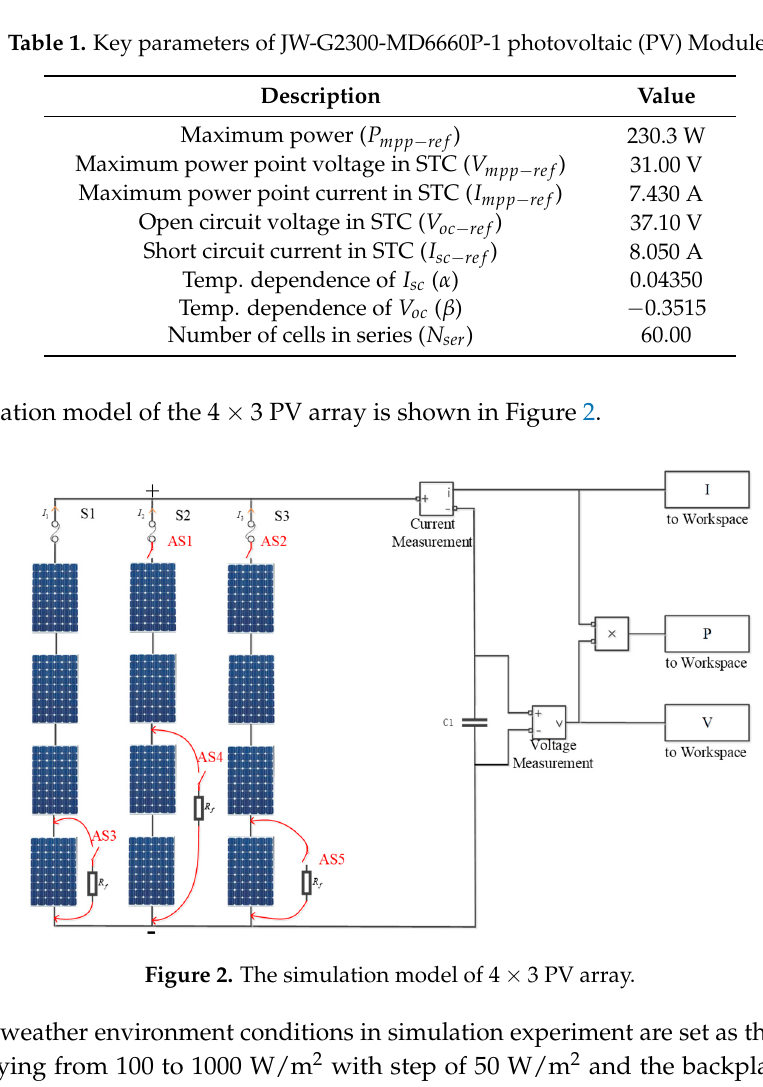
Table 2. Eight fault categories description.